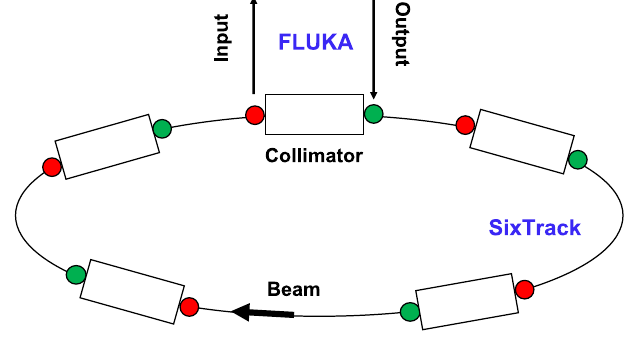
FIG. 4. S IX T RACK - FLUKA coupling principle.